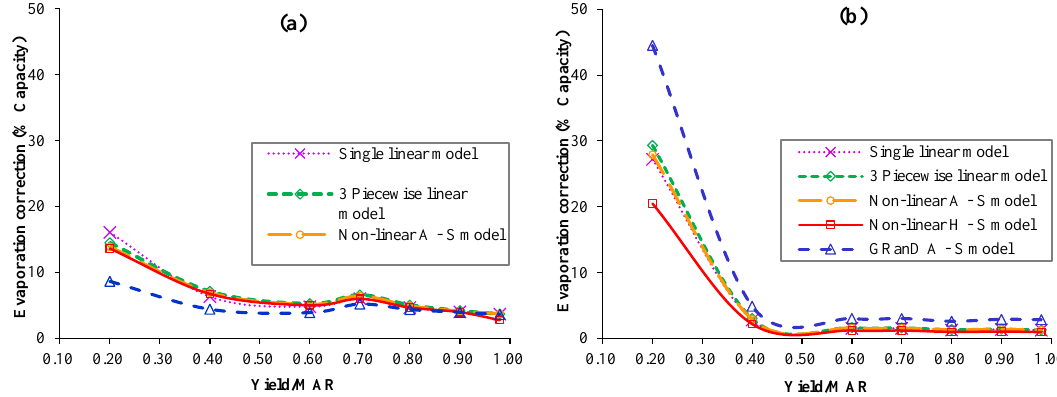
Figure 7. Evaporation correction as % of capacity in ( a ) Pong and ( b ) Bhakra